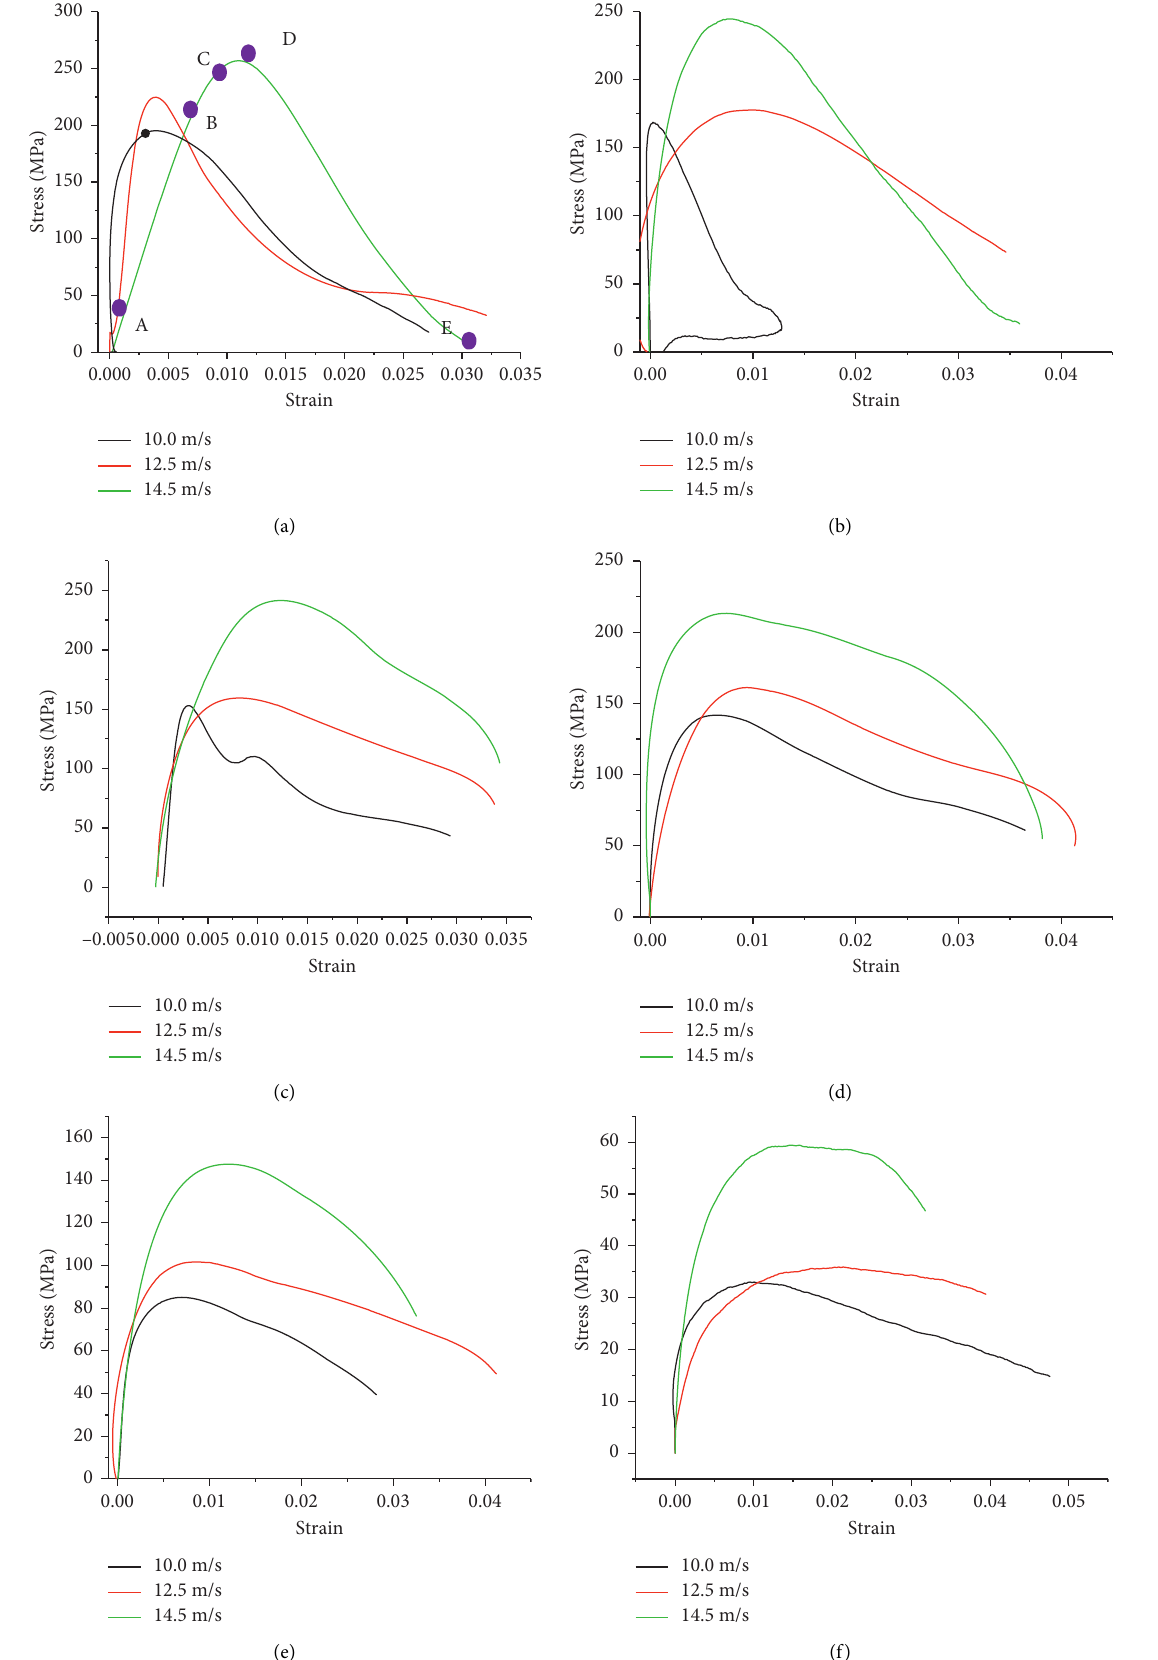
Figure 14: Stress-strain curves of rock under different impact speeds and different temperatures. (a) 25 ° C. (b) 100 ° C. (c) 200 ° C. (d) 400 ° C. (e) 600 ° C. (f) 800 °